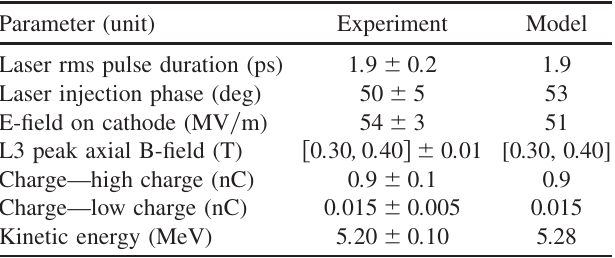
TABLE I. Nominal accelerator settings during the experiment. The ‘‘Experiment’’ and ‘‘Model’’ columns respectively corre- spond to values inferred from the AWA control system and values obtained when matching the impact-T model to the single-particle